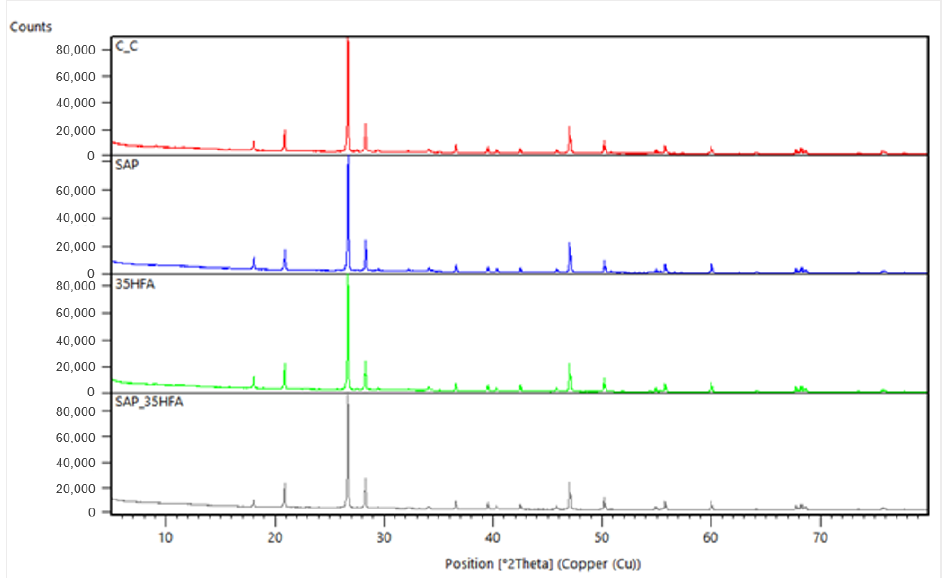
Figure 15. X-ray diffraction analysis—comparison of samples.